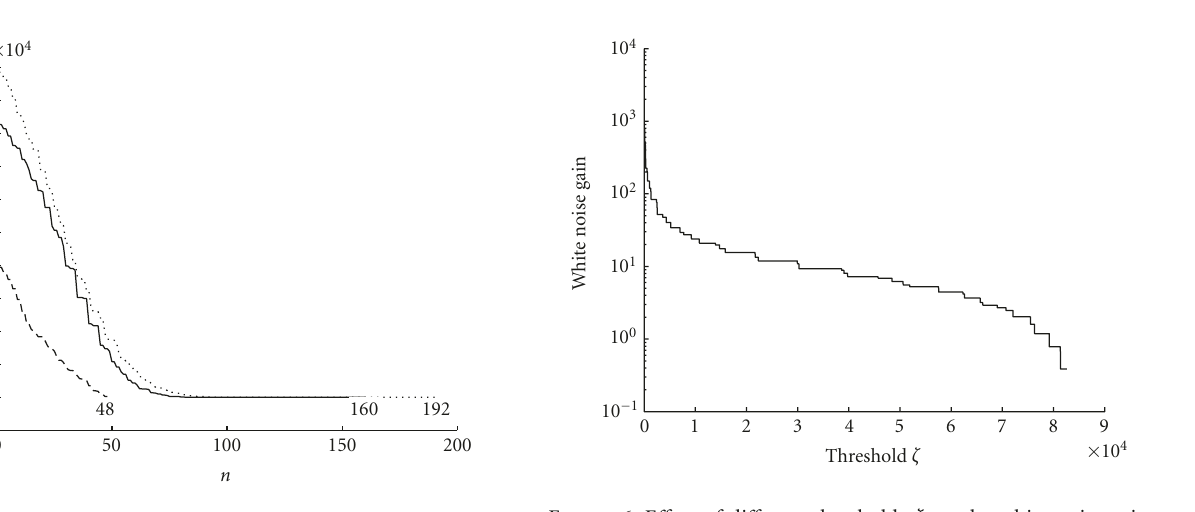
Figure 6: E ff ect of di ff erent thresholds ζ on the white noise gain (cid:11) w (cid:11) 2 for a 5-element, 32-time-sample